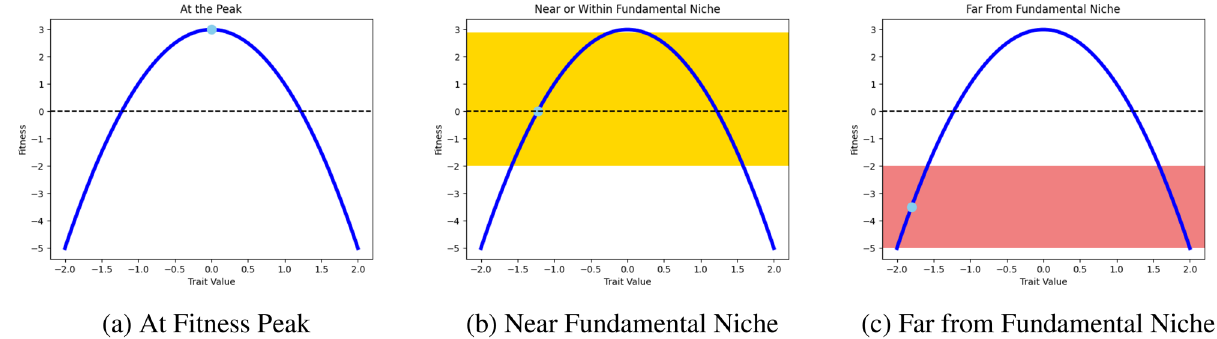
Figure 2. When evolutionary triage and self-genetic modification occurs. The curves depicted here are sample, schematic adaptive landscapes. They are not representative of any underlying biological phenomenon, but are rather provided as an illustration of what happens when species are at, close to, or far from an evolutionary peak. When cells are at a fitness peak ( a ), technically, due to a lack of selection pressure, no evolution occurs. When cells are bobbing near the sea level ( b ), only evolutionary triage occurs. When cells are drowning ( c ), primarily self-genetic modification occurs, though evolutionary triage can still occur via the 2N+